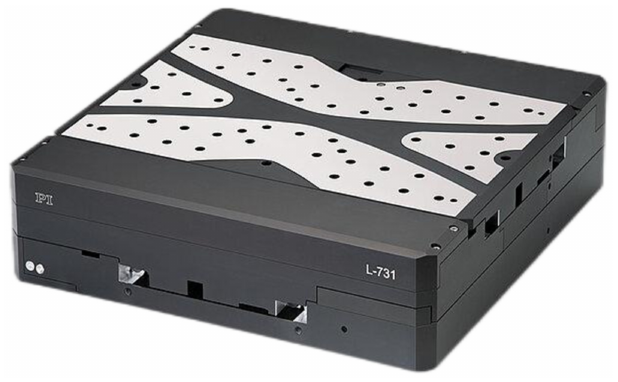
Figure 7. The XY precision shift stage. Table 5. The core parameters of the proposed sub-pixel shift